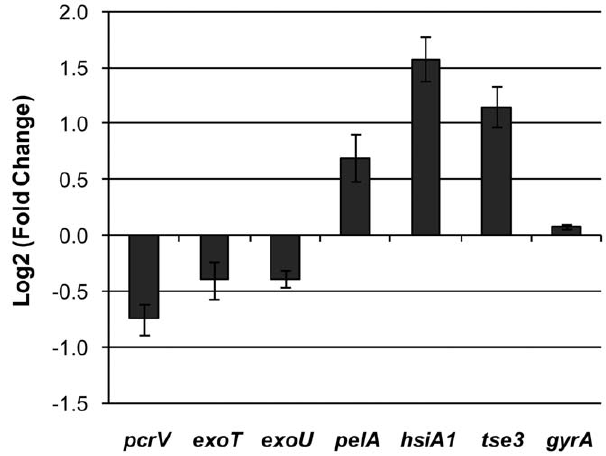
Figure 3. qRT-PCR analysis of target genes in ladS R compared to PA14. Positive values indicate that mRNA levels are higher in ladS R . All mRNA levels have been normalized to 16S rRNA.